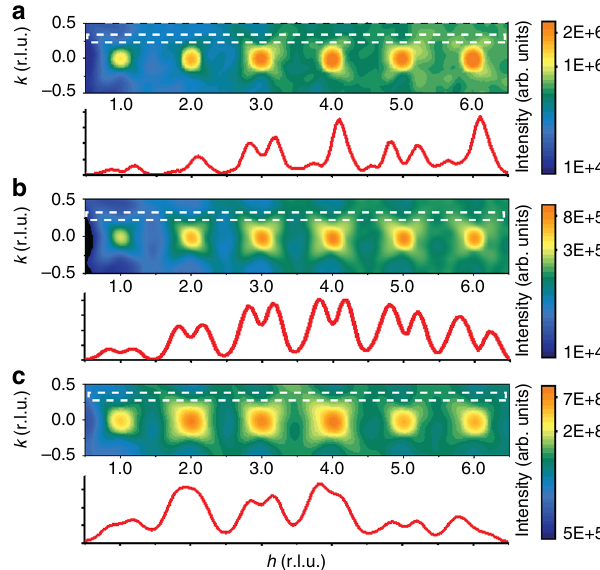
Fig. 5 Simulated neutron diffuse scattering. a , b Neutron diffuse scattering near the h 00 re fl ections ( h is the horizontal axis) calculated for the re fi ned con fi guration at 300 K with ( a ) all the species and ( b ) only the Pb atoms included in the calculations. c X-ray diffuse scattering near the same re fl ections with all the species included in the calculations. The intensity traces correspond to the k -positions indicated using white/dotted rectangles; the logarithmic intensity scales are the same as indicated in the corresponding color-scale bars. The neutron scattering in ( a ) is modulated relative to ( b ), featuring different appearance for the asymmetry of the h 00 re fl ections with h = 2 n and h = 2 n + 1. This modulation, which is associated with the correlated oxygen displacements, reproduces the experimental results reported in ref. 18 , even though the present re fi nements did